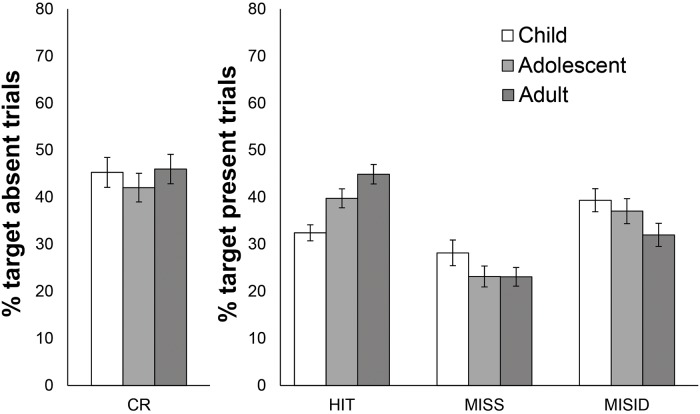
Face matching performance by age of target face in Experiment 1.Performance is expressed as correct rejection (CR), hit, miss and misidentification (MISID) rates. Error bars denote standard error.